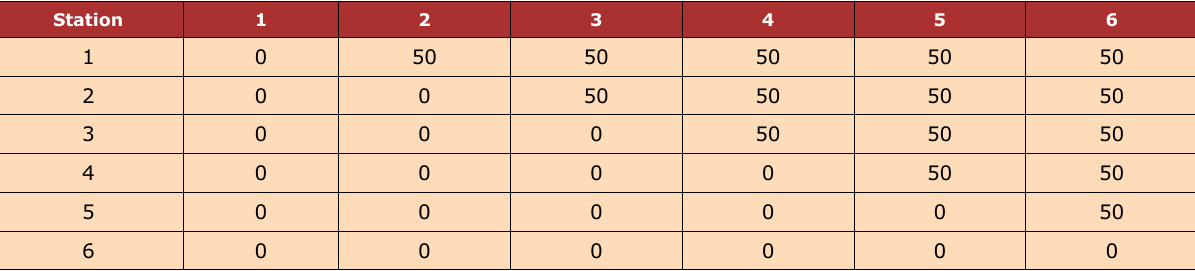
Table 1. OD passenger flows of case #1